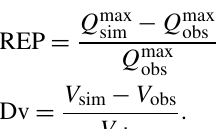
Figure 8. The percentage of hours subjected to incorrect wet–dry classification (false negative or false positive), with respect to high- rain-rate and low-rain-rate events. The box plots display the median, the 0.25 (lower) and 0.75 (upper) quantiles, outliers (computed us- ing the interquartile range), and the minimum and maximum values excluding any outliers.